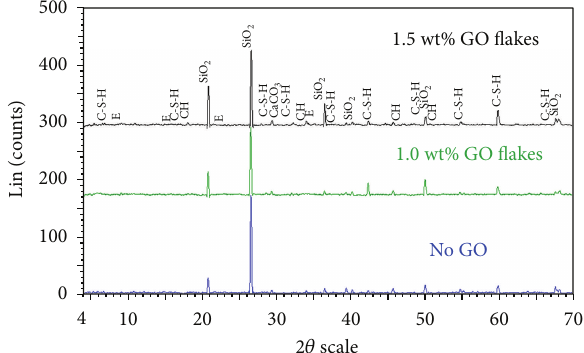
Figure 12: X-ray diffractogram of GO-cement nanocomposites containing 1 and 1.5wt% GO flakes and control sample (without any GO flakes) after 28 days of